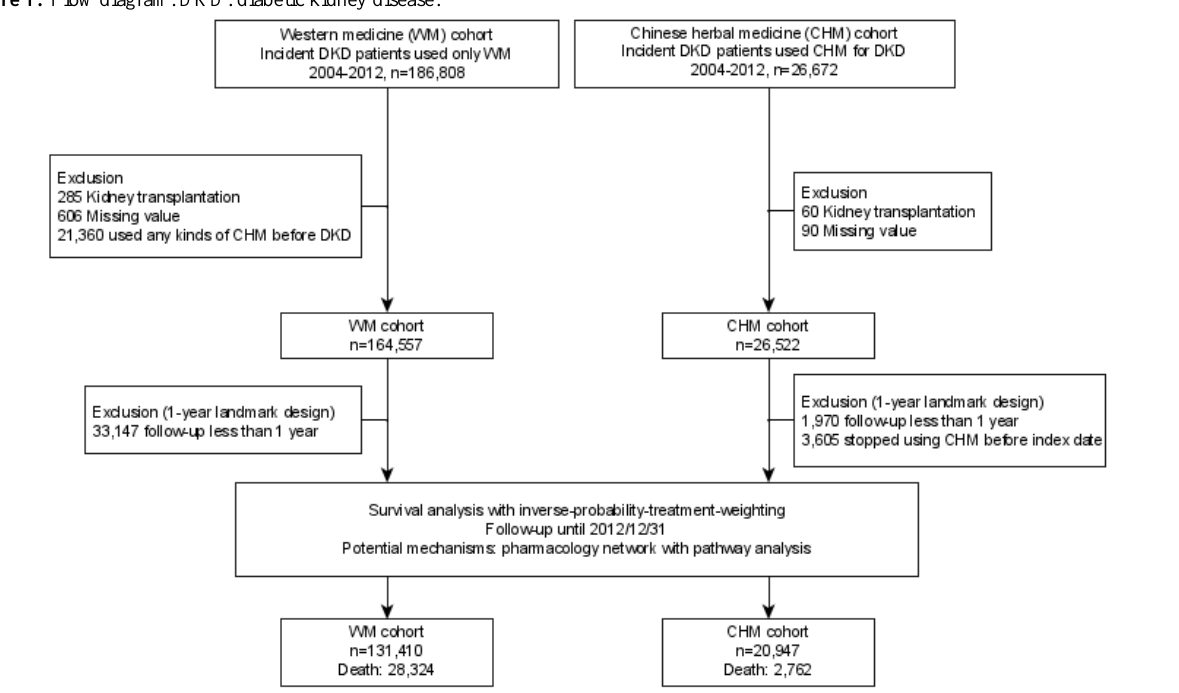
Figure 1. Flow diagram. DKD: diabetic kidney disease.